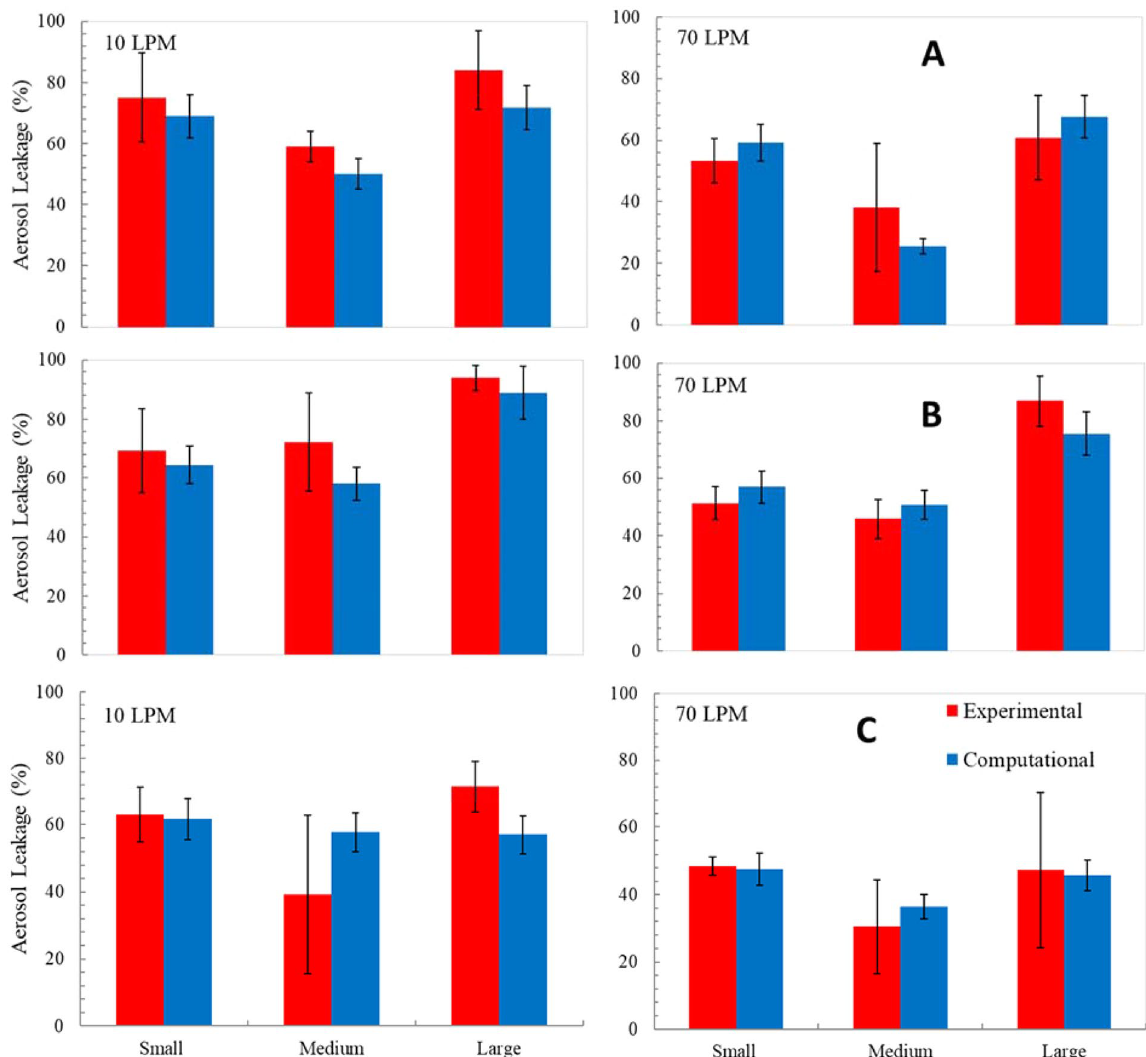
Figure 9. Experimental and computational aerosol leakage percentage for 10 LPM and 70 LPM ( A ) Respirator, R1 ( B ) Respirator, R2 ( C ) Respirator, R3; n = 3 for